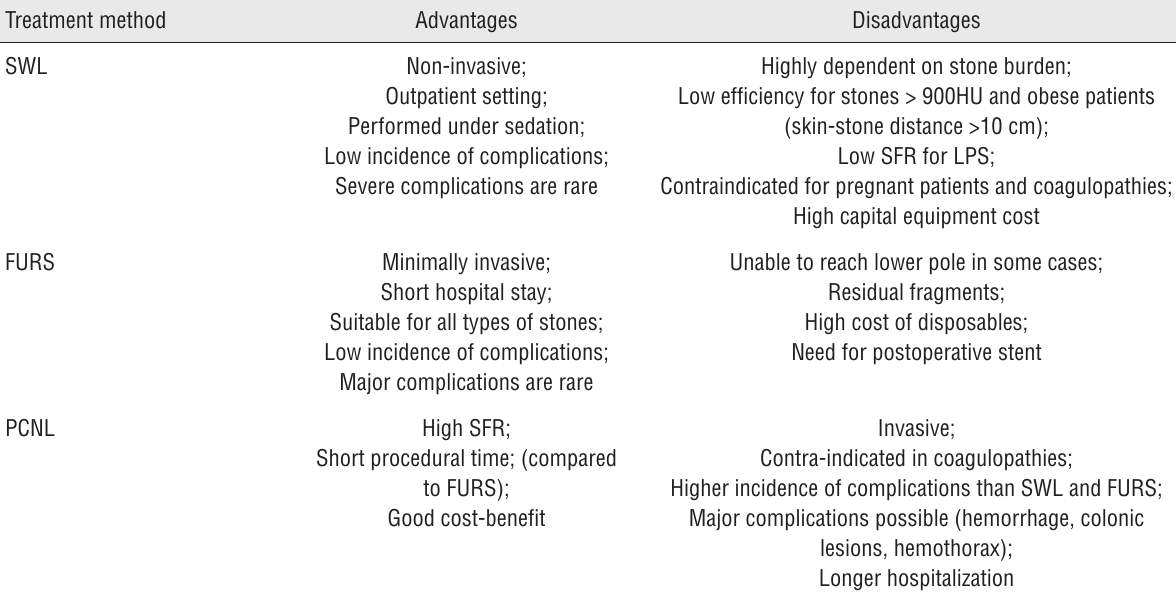
Table 1 - Advantages and Disadvantages of methods for LPS treatment (modified from Moore SL et al.) (23). Treatment